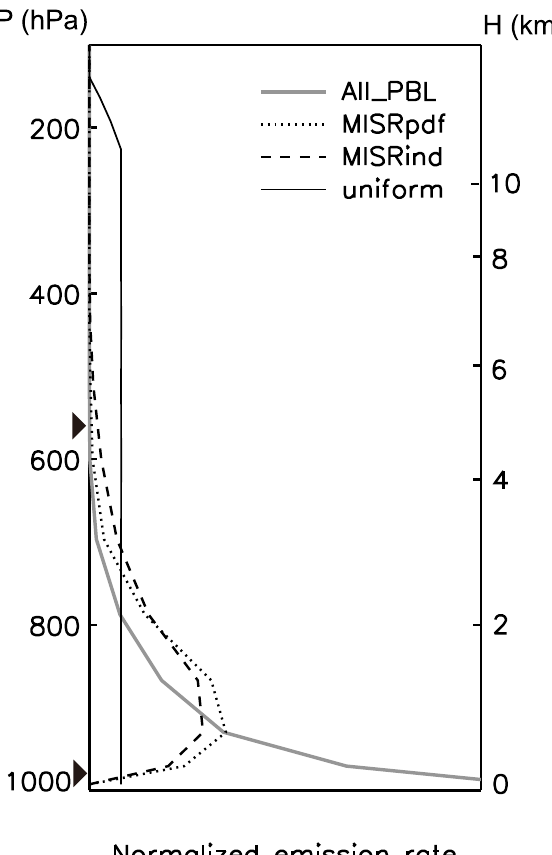
Fig. 3. Vertical profiles for releasing biomass burning emissions in Alaska and western Canada during summer 2004, calculated using All PBL , MISRpdf , MISRind , and uniform injection height distri- butions as described in Table 1. The two triangles represent the altitudes of maximum and minimum injection heights as observed by MISR in Alaska and western Canada during summer